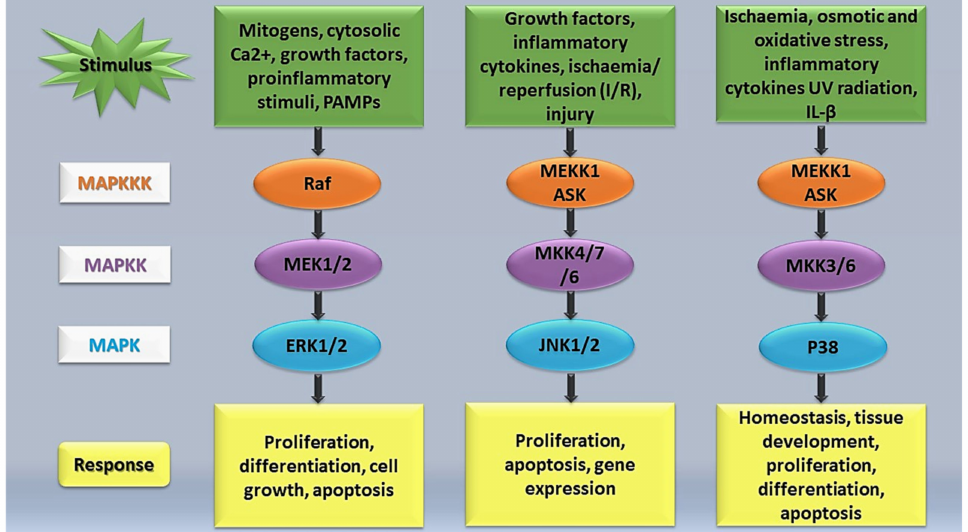
Figure 1. Simplified overview of the MAPK signalling